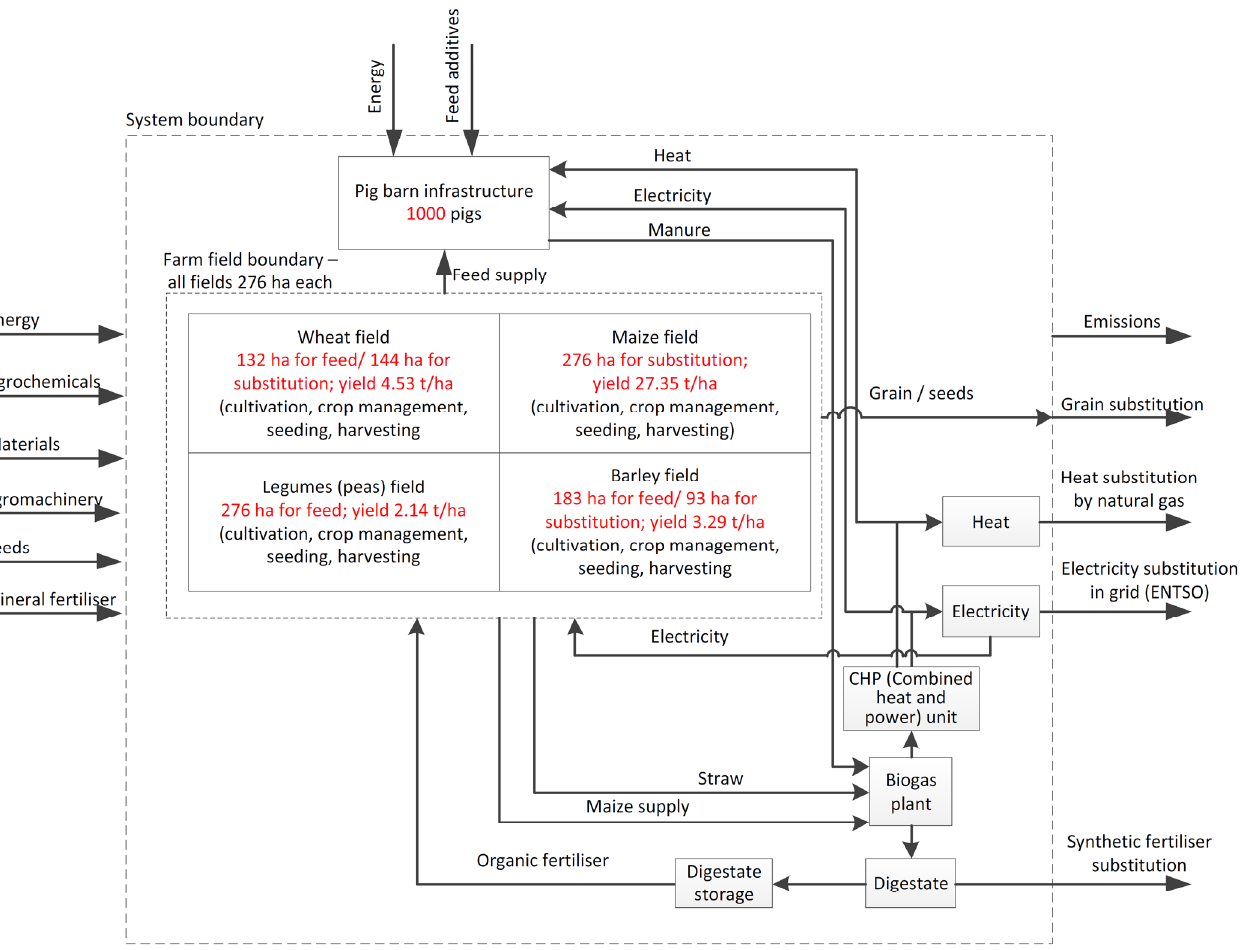
Figure 4. Schematic representation of the main processes and pathways considered for the pig farm in SC3.